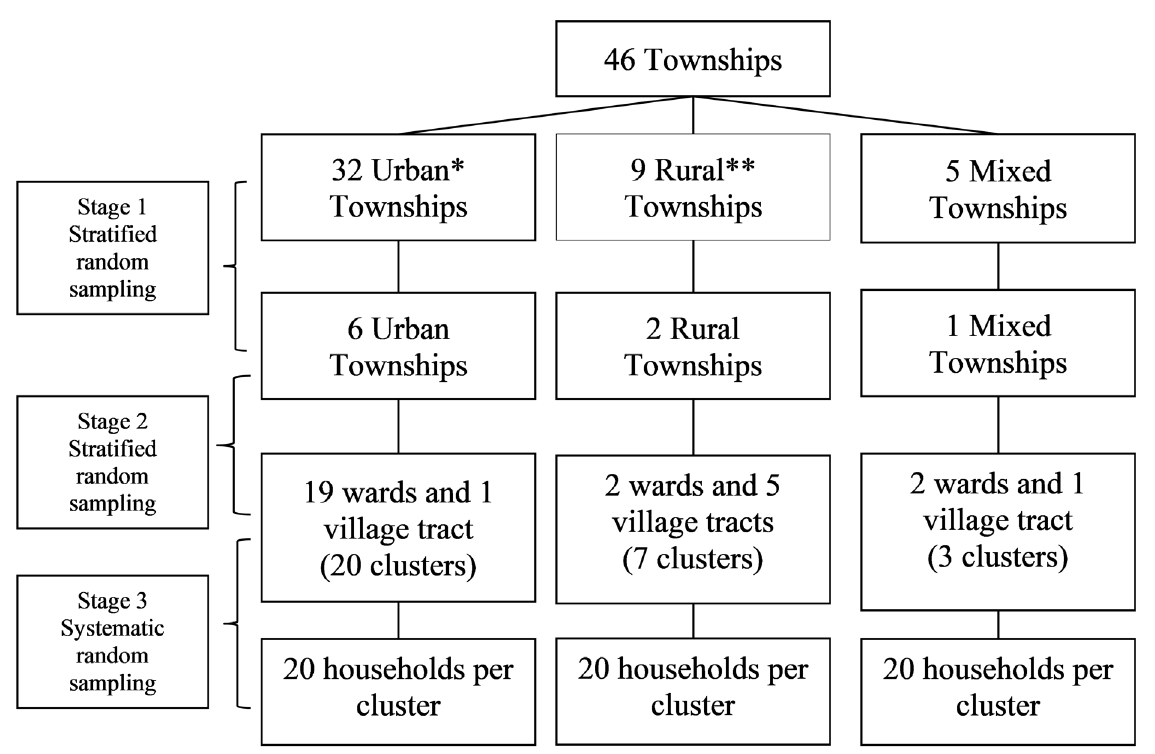
Figure 1. Multi-stage random sampling (three stage) to select households with 1–15 year-old children in the Japanese encephalitis survey, Yangon region, Myanmar (2019). *Predominantly urban (>70% urban population); **Predominantly rural (>70% rural